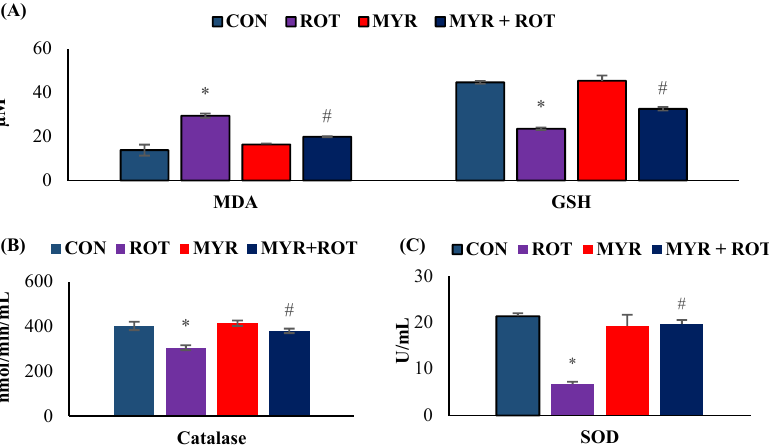
Figure 1. The effect of myrcene on oxidative stress markers MDA and GSH ( A ) and antioxidant defense markers CAT and SOD ( B , C ). The values are expressed as mean ± SEM ( n = 6–8). * p < 0.05 (ROT vs. CON), # p < 0.05 (MYR vs. ROT).